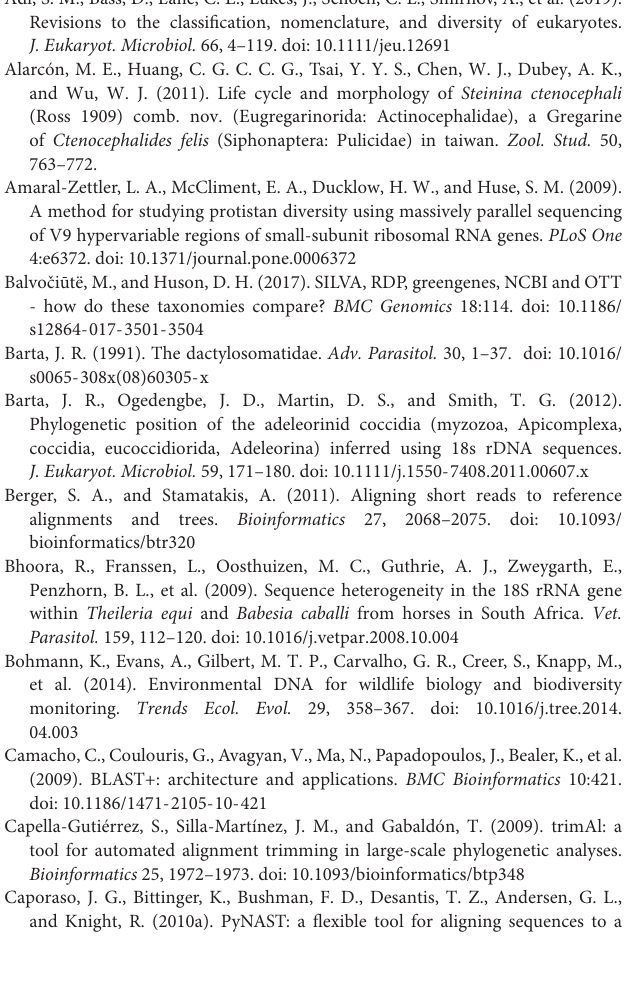
TABLE S2 | Taxonomic summary of the HTES reads at the genus level. TABLE S3 | Depth and coordinates for the Monterey Bay deep-sea sediment